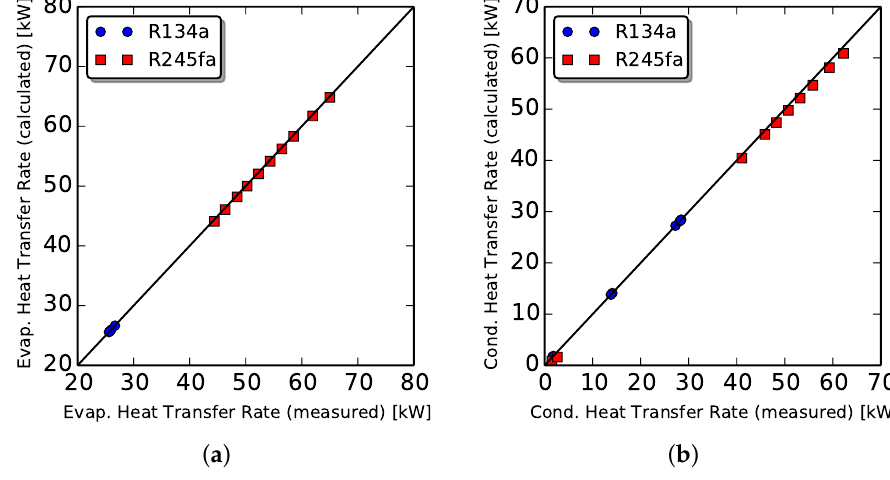
Figure 11. Validation of the PHEX model employed as: ( a ) Evaporator; ( b ) Condenser. 20 steady-state points are shown in the parity plots.